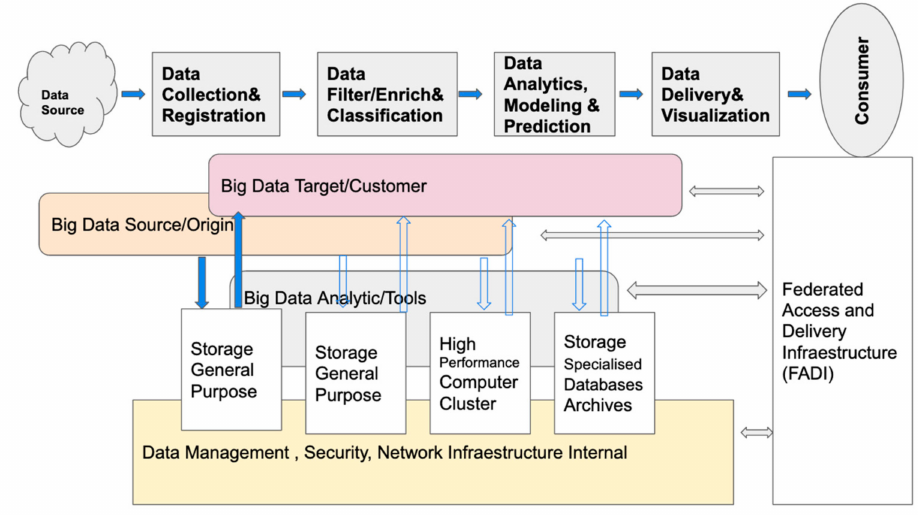
Figure 1. General architecture of Big